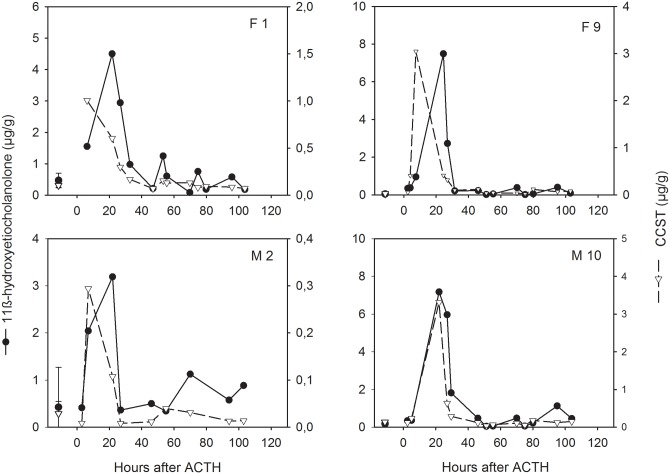
Representative profiles of immunoreactive 11β-hydroxyetiocholanolone (black circles) and CCST (white triangles) in two female (top) and male (bottom) meerkats after administration of ACTH at time 0.Data points before time 0 represent median ± SE concentrations (μg/g) of pre-treatment samples collected 5–8 days before ACTH injection.